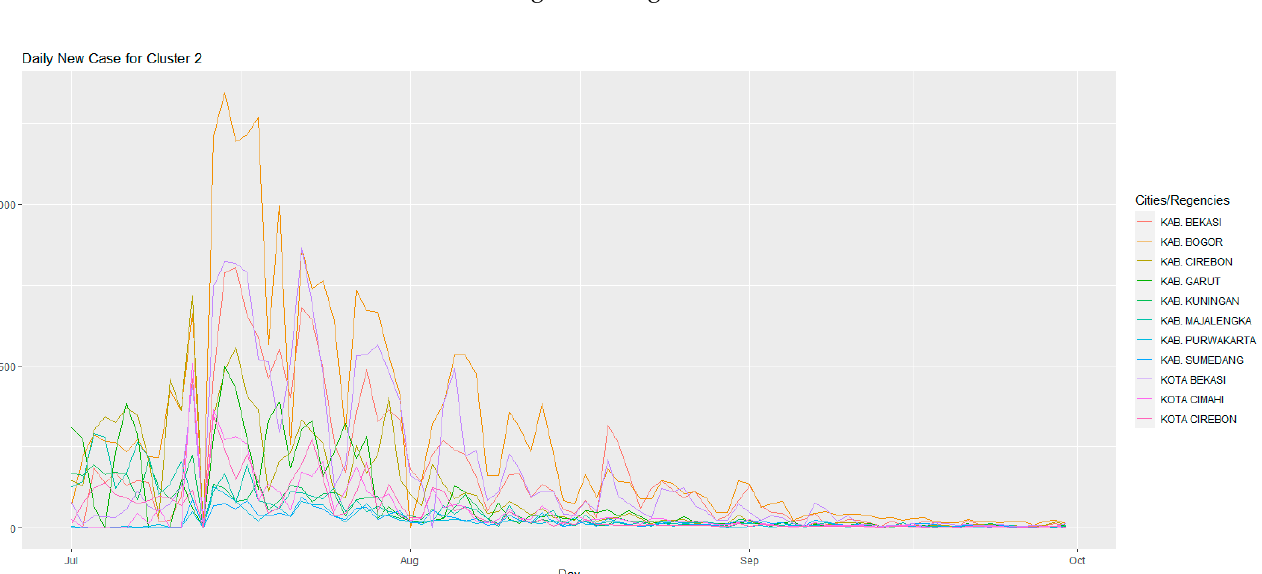
Figure 6. Daily positive cases of COVID-19 in Cluster 3 for the first period. Figure 7 shows the development of daily positive cases of COVID-19 in Cluster 4. This cluster is unique because it only consists of one city, the same as Cluster 3, namely Depok City. The unique characteristic that can be observed through the graph in this clus- ter is that it can be seen that this cluster experiences a peak or worst-case scenario in dif- ferent periods when compared to other clusters. This cluster peaked on 21 August 2021– 26 August 2021, and this happened suddenly. In contrast to other clusters, which in the same period actually decreased, when the emergency PPKM and Level 4 PPKM were im- plemented, this cluster experienced a fluctuating number of daily positive cases of COVID-19. This cluster experienced a significant decline on 27 August 2021. At that time, the number of daily cases that occurred was 110 cases, very different from the previous day where the number of daily positive cases was 3341 cases. Furthermore, during 28 Au- gust 2021–30 September 2021, this cluster experienced a steady decline. This cluster is